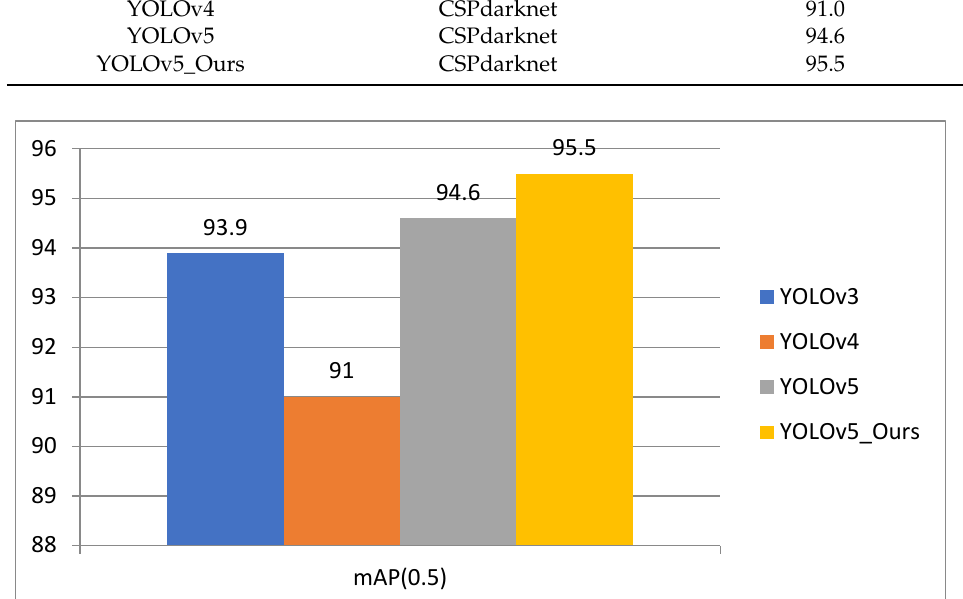
Figure 15. Comparison graph of result values for Previous YOLO models and YOLOv5_Ours model.